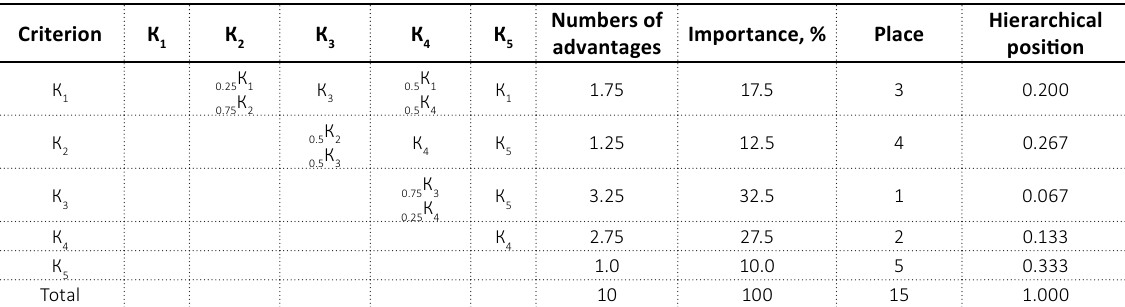
Table 1. Matrix of the logistic evaluation of criteria for choosing the suppliers at the market of the material resources